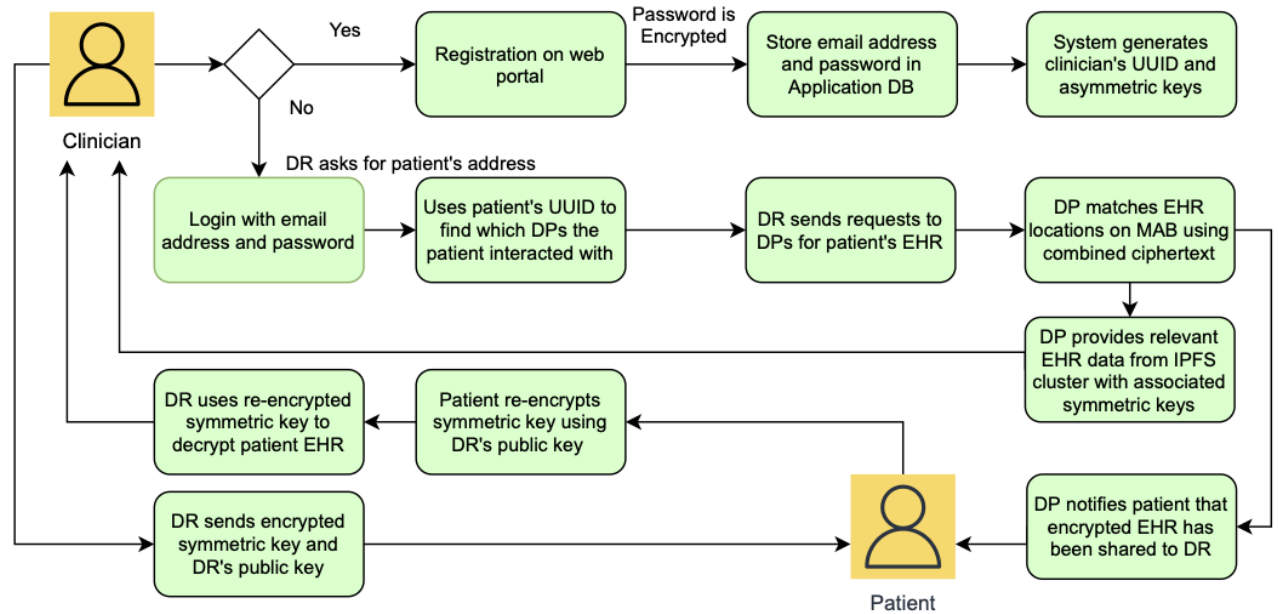
Figure 14. Data requester and EHR distribution flow diagram.